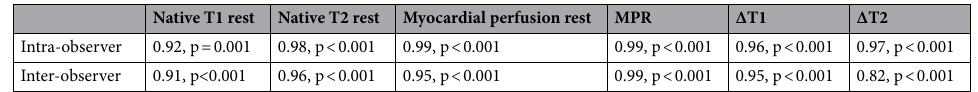
Table 6. Intra- and inter-observer variability presented as ICC and p-values. MPR myocardial perfusion